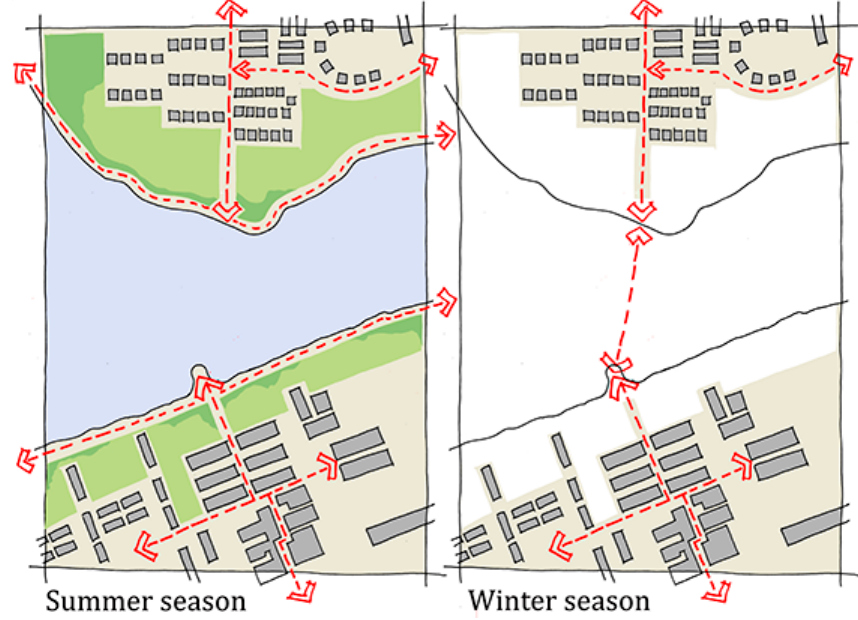
Figure 5. A sketch of how frozen water can enable new connections between neighborhoods.